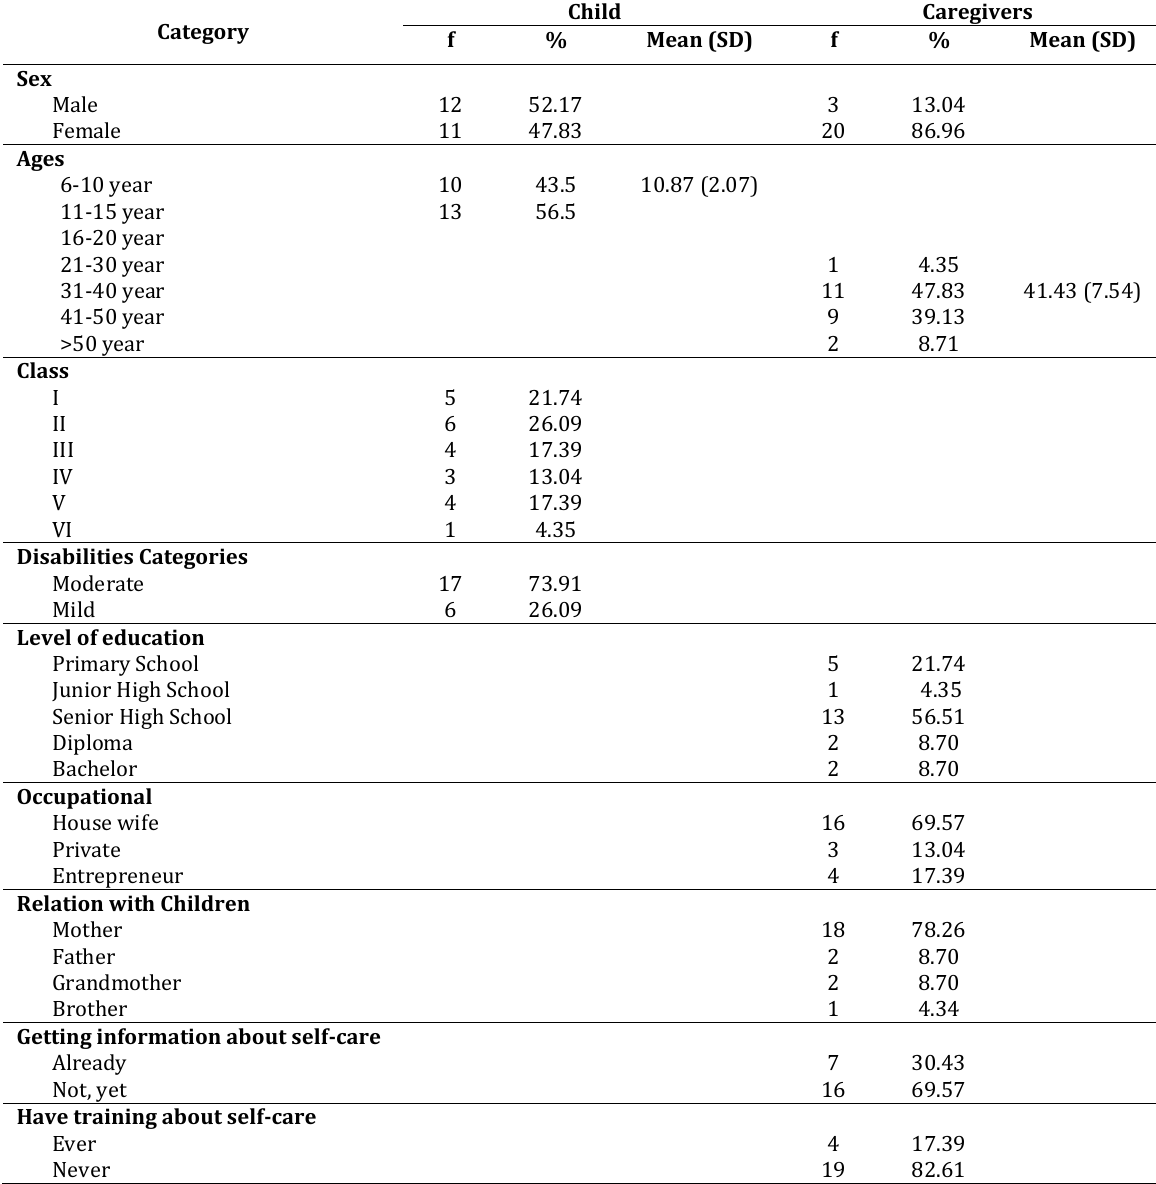
Table 1. Distribution of Respondents of Children and Caregivers Meeting the Research Criteria at YPAC Surakarta March-April 2017 (n=